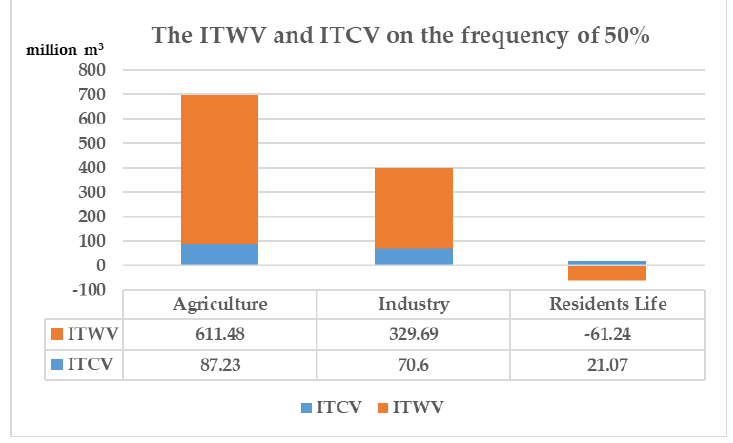
Figure 4. The ITWV and ITCV of industry on the frequency of 50%. (ITWV is short for tradable water volumes of industry. ITCV is short for tradable control volumes of industry.).